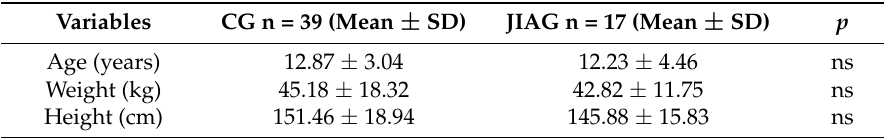
Table 1. Description of the anthropometric characteristics of the